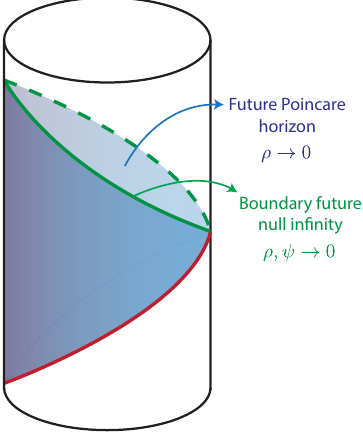
Figure 3 . Diagram representing the region of global AdS 3 (solid cylinder) covered by the Poincaré patch (solid blue region) in the coordinates in (5.4). While the future boundary of the bulk Poincaré patch is given by ρ → 0 , the future null infinity of the AdS boundary (the boundary of the boundary) is located at ρ, ψ → 0